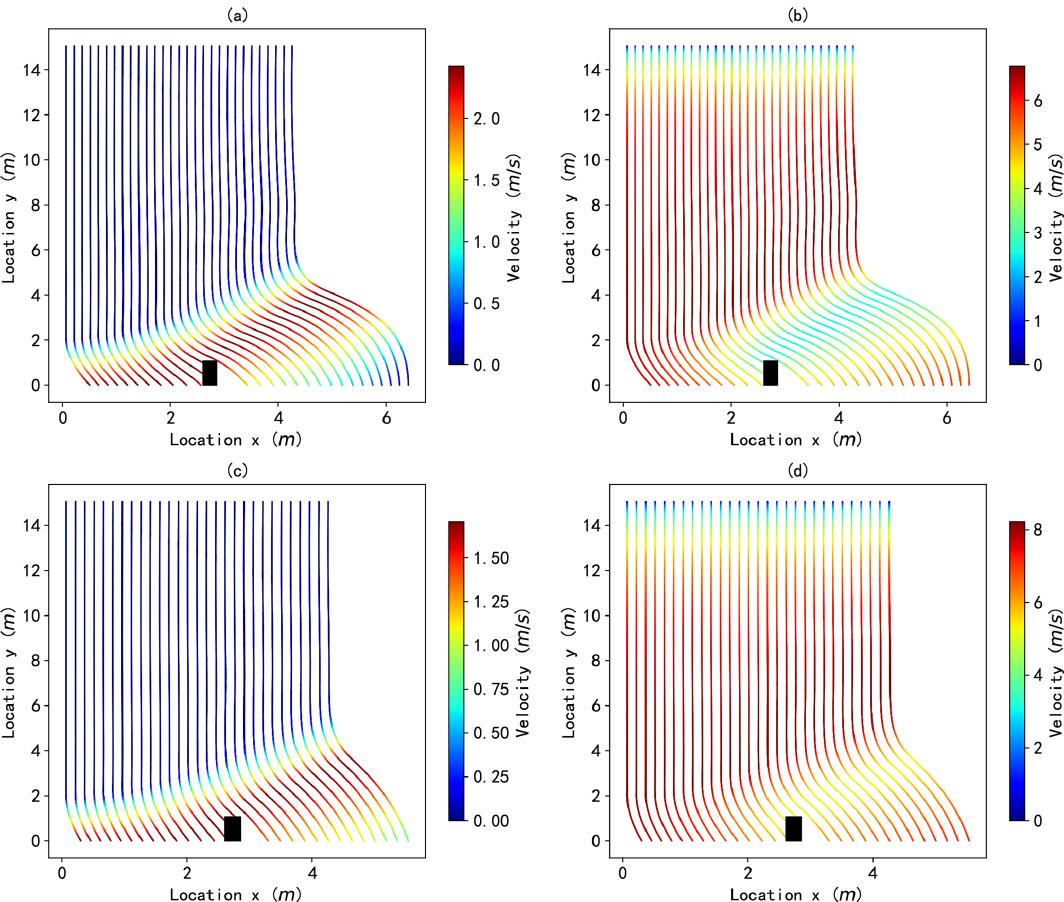
Figure 9. The trajectory and velocity of raindrops. The line represents the trajectory, and the color represents the velocity. Panels (a) and (b) represent the horizontal and vertical velocities, respectively, for the drops of rainfall 1 under wind 5. Panels (c) and (d) represent the horizontal and vertical velocities, respectively, for the drops of rainfall 2 under wind 5. Location x means horizonal position, while Location y means vertical position in a 2D plane space.